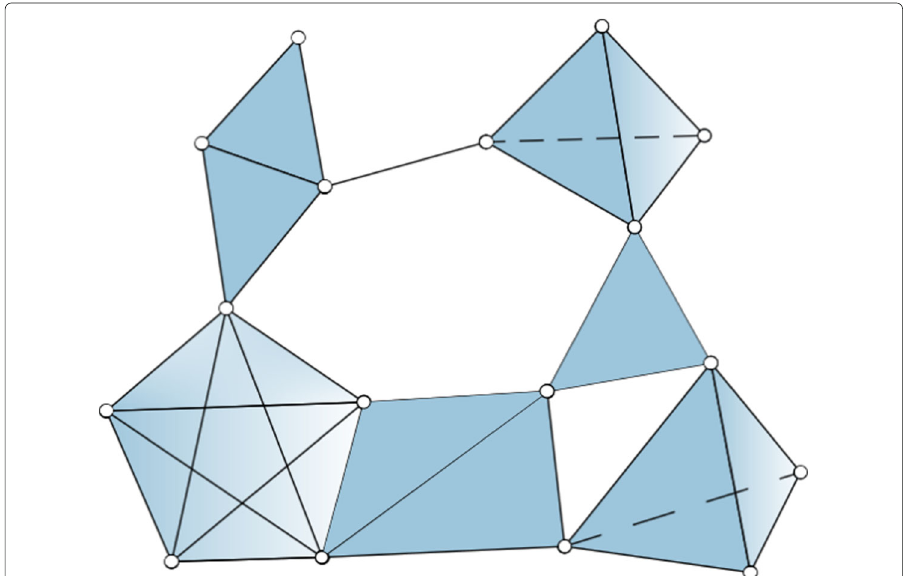
Fig. 4 2-skeleton of a 4-complex in 3. As can be seen 1-dimensional holes are preserved, while 2-dimensional holes are not, in particular there are 3 H 2 -holes that were not in the original complex, namely those inside the two 3-simplices, and one inside the